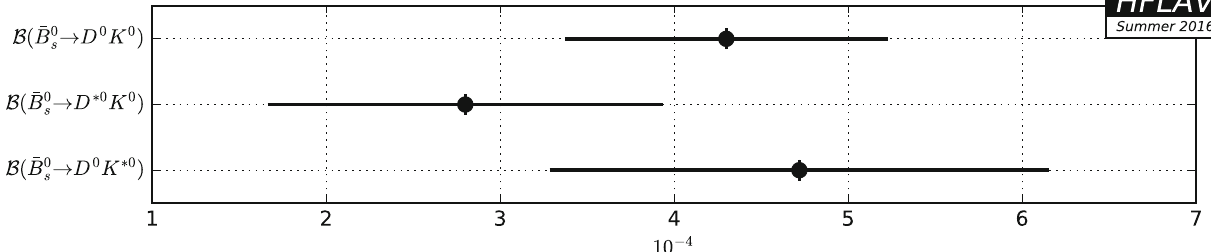
Fig. 154 Summary of the averages from Table 188